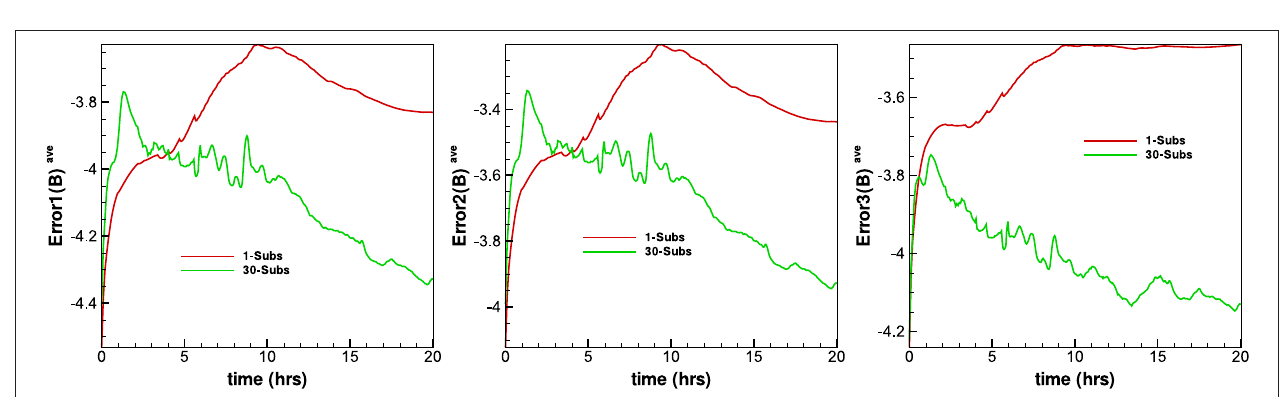
FIGURE 15 | The temporal evolution of the log 10 Error1 (B) ave and log 10 Error2 (B) ave and log 10 Error3 (B) ave from the diffusive method with different maximal